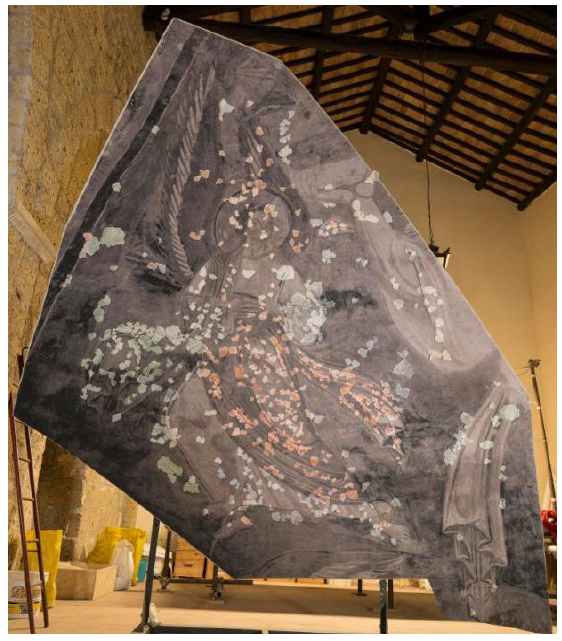
Figure 15. The support structure built by the restorers on which it is possible to see the remaining pieces of the original fresco.